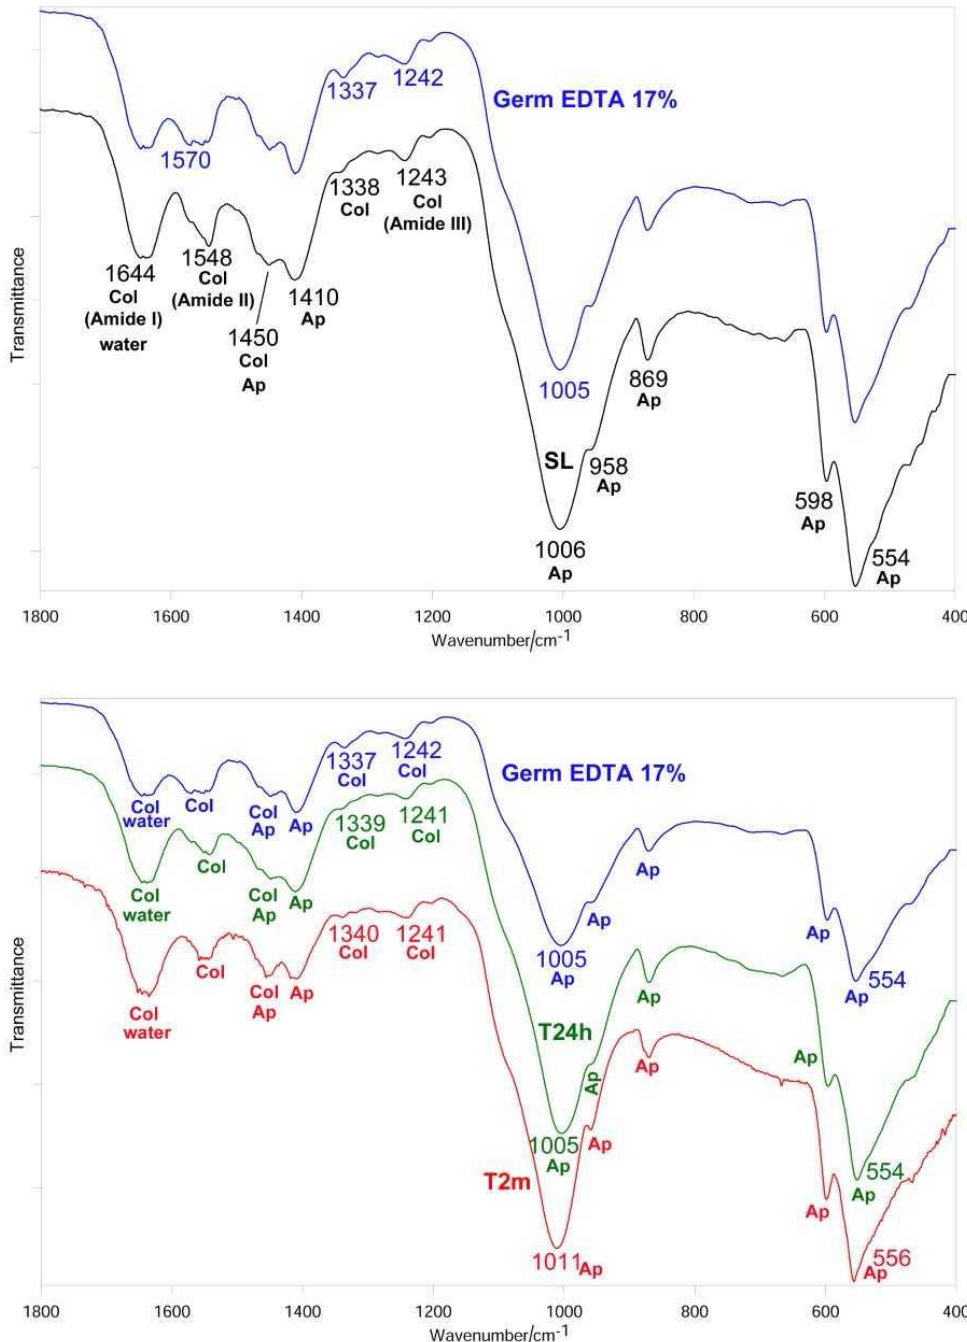
Figure 8. Average IR spectra recorded on the dentin surface after sanding (SL, black), treatment with 17% EDTA (Germ EDTA 17%) (blue), aging in SBF for 24 h (T24h, green) and two months (T2m, red). The bands prevalently assignable to collagen (Col), water, and B-type carbonated apatite (Ap) are indicated.